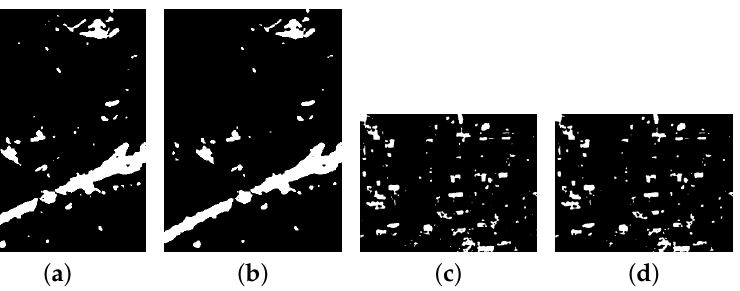
Figure 15. Ablation study of multimodal conditional random field on the OSCD dataset. ( a ) MSAK- Net of Montpellier, ( b ) MSAK-Net-MCRF of Montpellier, ( c ) MSAK-Net of Lasvegas, ( d ) MSAK-Net- MCRF of